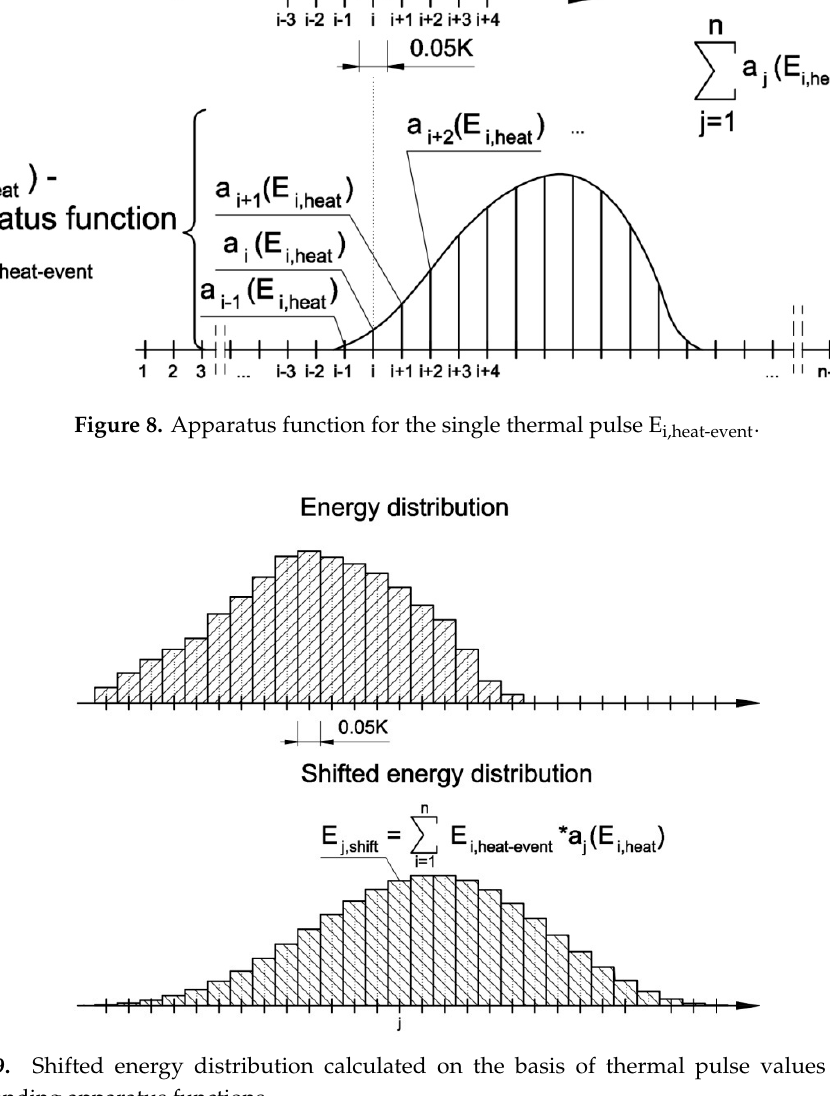
Figure 9. Shifted energy distribution calculated on the basis of thermal pulse values and the corresponding apparatus functions.